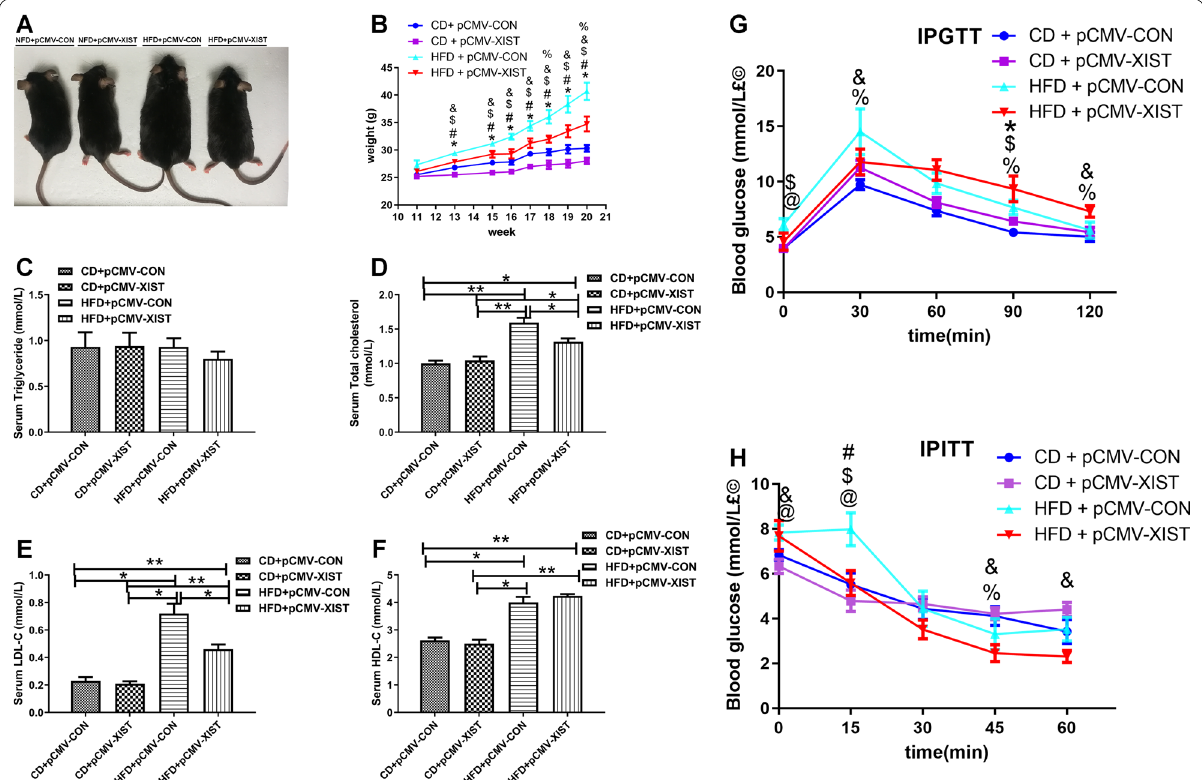
Fig. 4 XIST overexpression attenuates HFD-induced obesity in vivo. A Representative photograph of male mouse whole body images between groups. B Body weight of male mice between groups. CD, chow diet. HFD, high fat diet. *CD p < 0.05; #